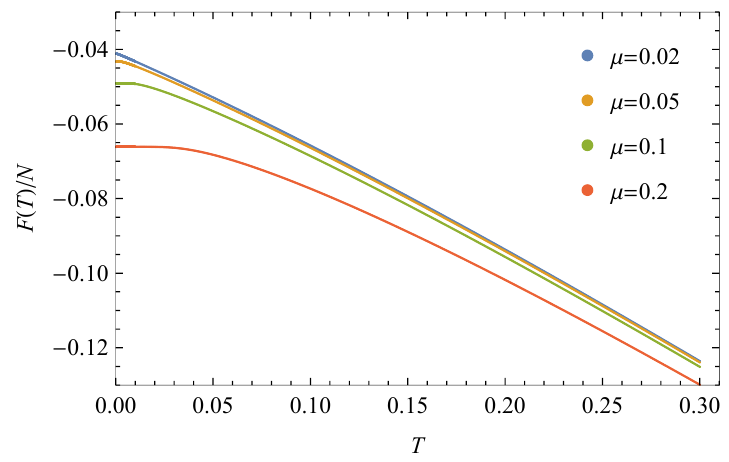
Figure 9 . The large N free energy F of the deformed SYK model (B.15) computed by solving N the Schwinger-Dyson equation numerically. Here the horizontal axis is the temperature T .